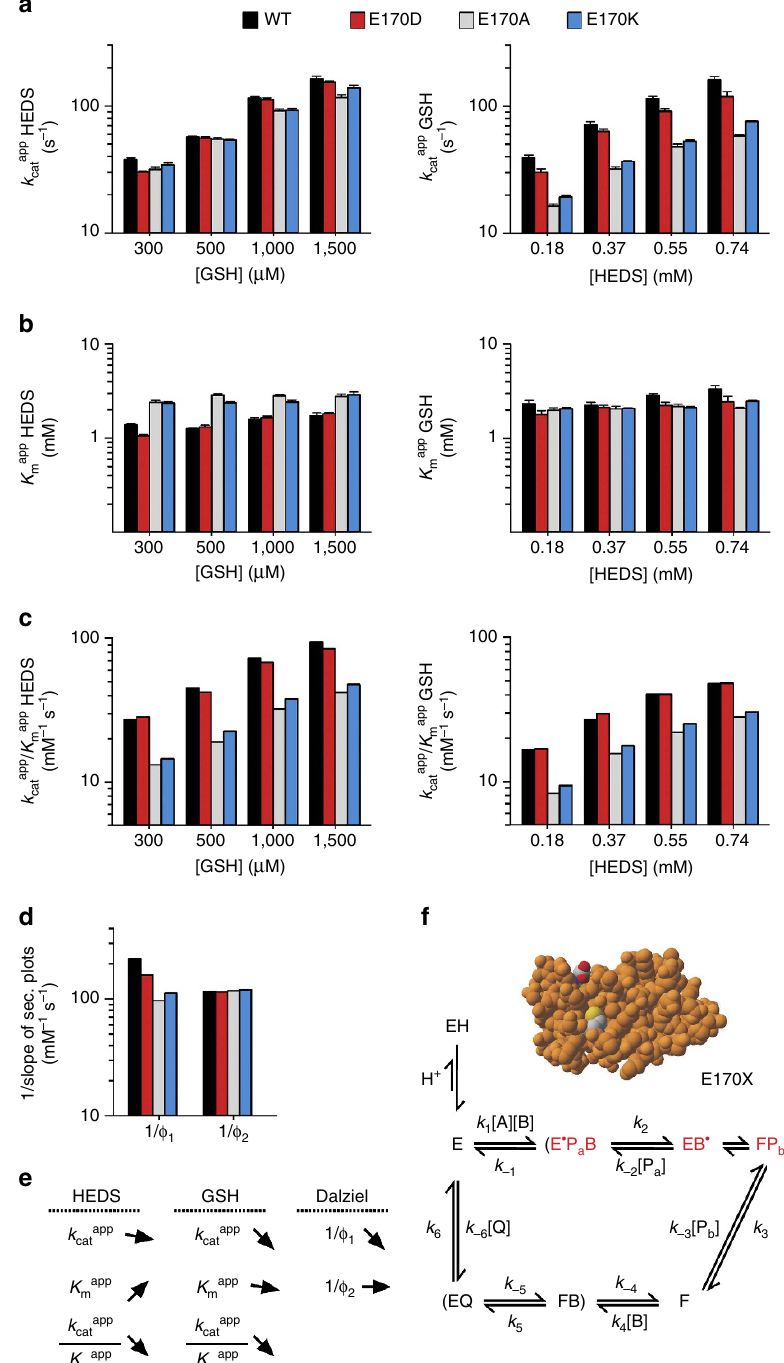
Figure 5 | Altered kinetics of E170X mutants support a glutathionylated disulfide substrate intermediate. ( a , b ) Selected k cat app and K m app values of ScGrx7 wild-type enzyme and E170X mutants for HEDS and GSH. ( c ) Calculated catalytic efficiencies from a and b . ( d ) Reciprocal Dalziel coefficients obtained from Supplementary Fig. 9. ( e ) Summary of the altered kinetic parameters. ( f ) Data interpretation based on a proposed catalytic mechanism with HEDS and GSH as true substrates 18 . Kinetically relevant enzyme species are labelled in red and comprise the mixed disulfide between the enzyme and 2-mercaptoethanol ‘E (cid:3) ’, an intermediate thiolate form ‘E’ and glutathionylated enzyme ‘F’. HEDS and GSH correspond to substrates A and B, respectively. GSSEtOH is the intermediate product and substrate ‘B (cid:3) ’. Two molecules of 2-ME and GSSG correspond to products P a,b and Q, respectively. Original plots and kinetic parameters for a – c are shown in Supplementary Fig. 8 and Supplementary Table 5 and are the mean ± s.d. from at least three independent replicates. Statistical analyses and P -values for the k cat app and K m app values from a and b are listed in Supplementary Table 11. Reciprocal Dalziel coefficients for d and true k cat values are listed in Supplementary Table